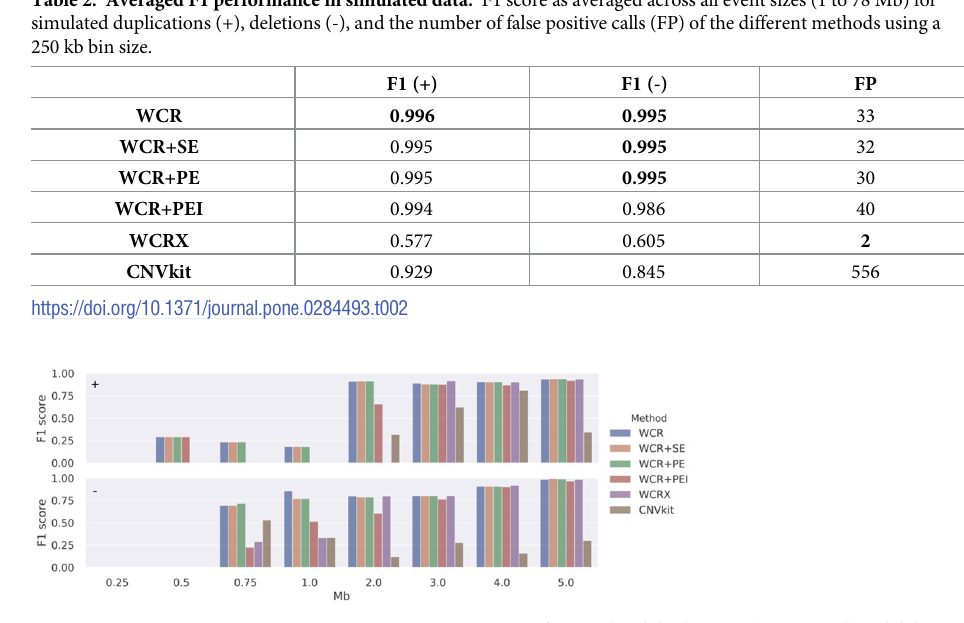
Fig 5. F1 performance in challenging simulated data. F1 score for simulated duplication (+, top panel) and deletion (-, bottom panel) events of varying sizes (0.25 to 5 Mb) at a fixed fetal fraction of 6% for the different methods using a 250 kb bin